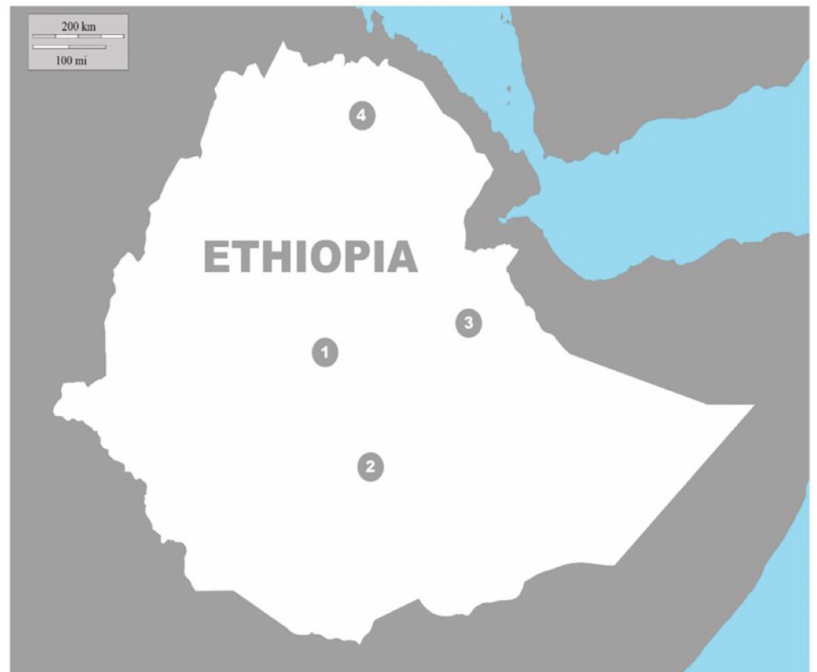
Figure 1. Location of four cities (1: Addis Ababa; 2: Arba Minch; 3: Harar; and 4: Mekelle) in Ethiopia where data were collected on spotted hyenas (1, 3, 4) and human perceptions and beliefs related to humans (2, 3, 4). Figure courtesy of B. Kartchner, Utah State